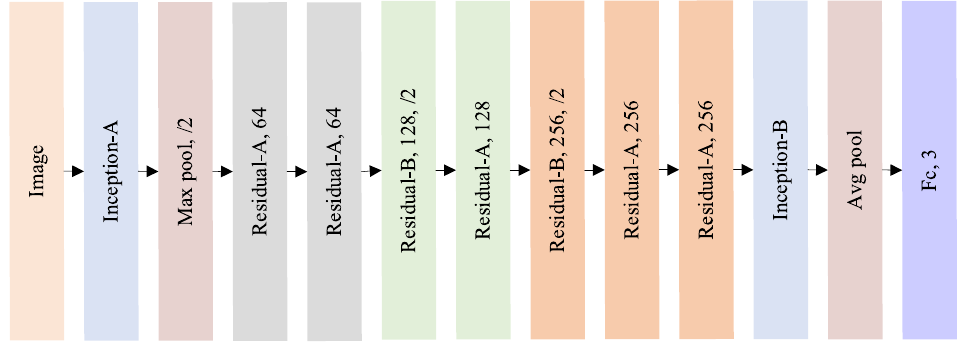
Figure 4. The architecture of the IRBOA model.